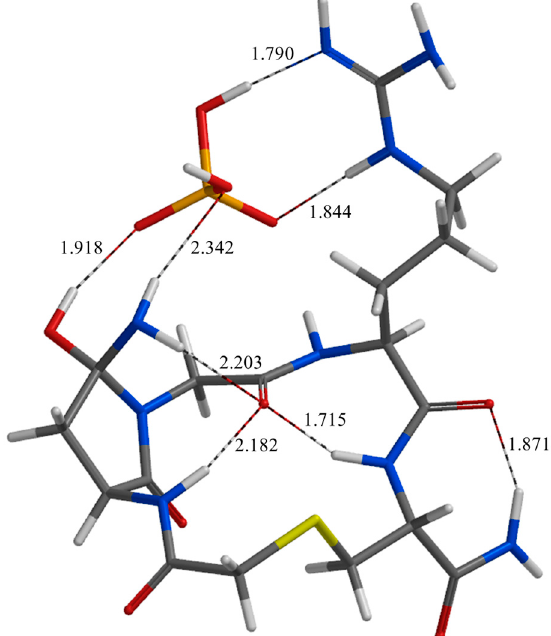
Figure 9. The geometry of IC3 (intermediate complex 3) lying between TS3 (Figure 8) and TS4 (Figure 10). Selected interatomic distances are shown in Å. Grey: carbon; white: hydrogen; blue: nitrogen; red: oxygen; orange: phosphorus; yellow: sulfur.